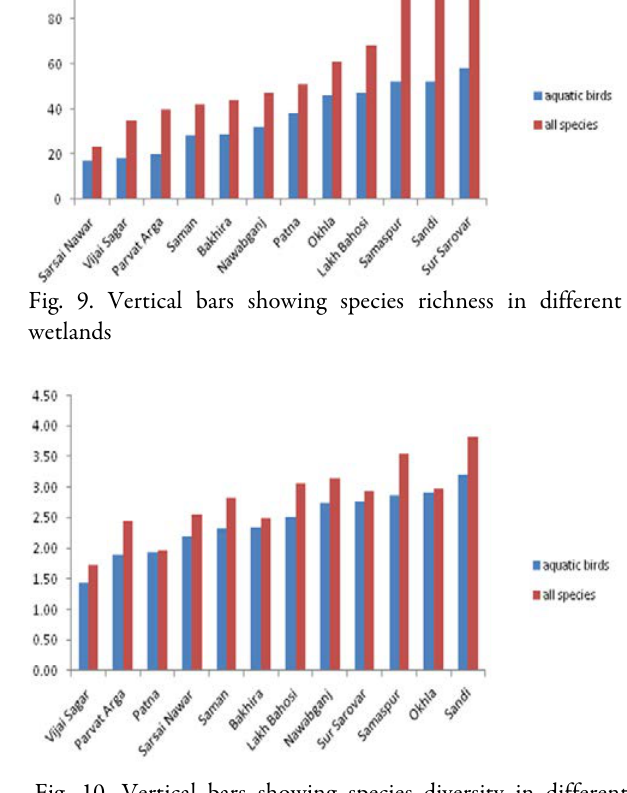
Fig. 10. Vertical bars showing species diversity in different